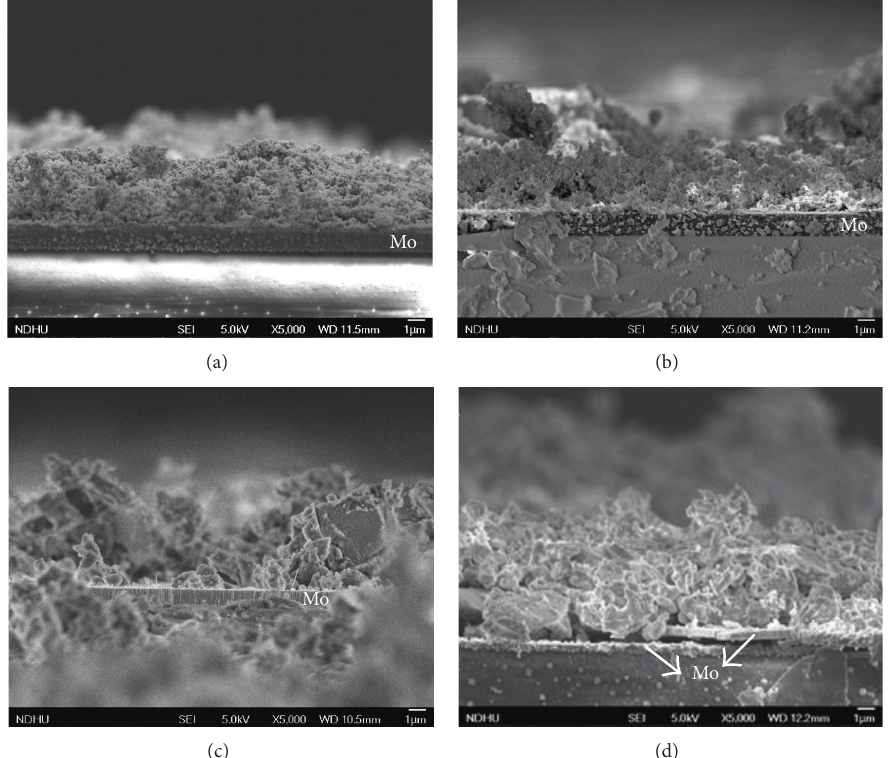
Figure 7: FE-SEM morphology cross-section of thin films deposition at potentials (a) − 1350 mV, (b) − 1550 mV, (c) − 1750mV, and (d) − 1950 mV versus SCE.